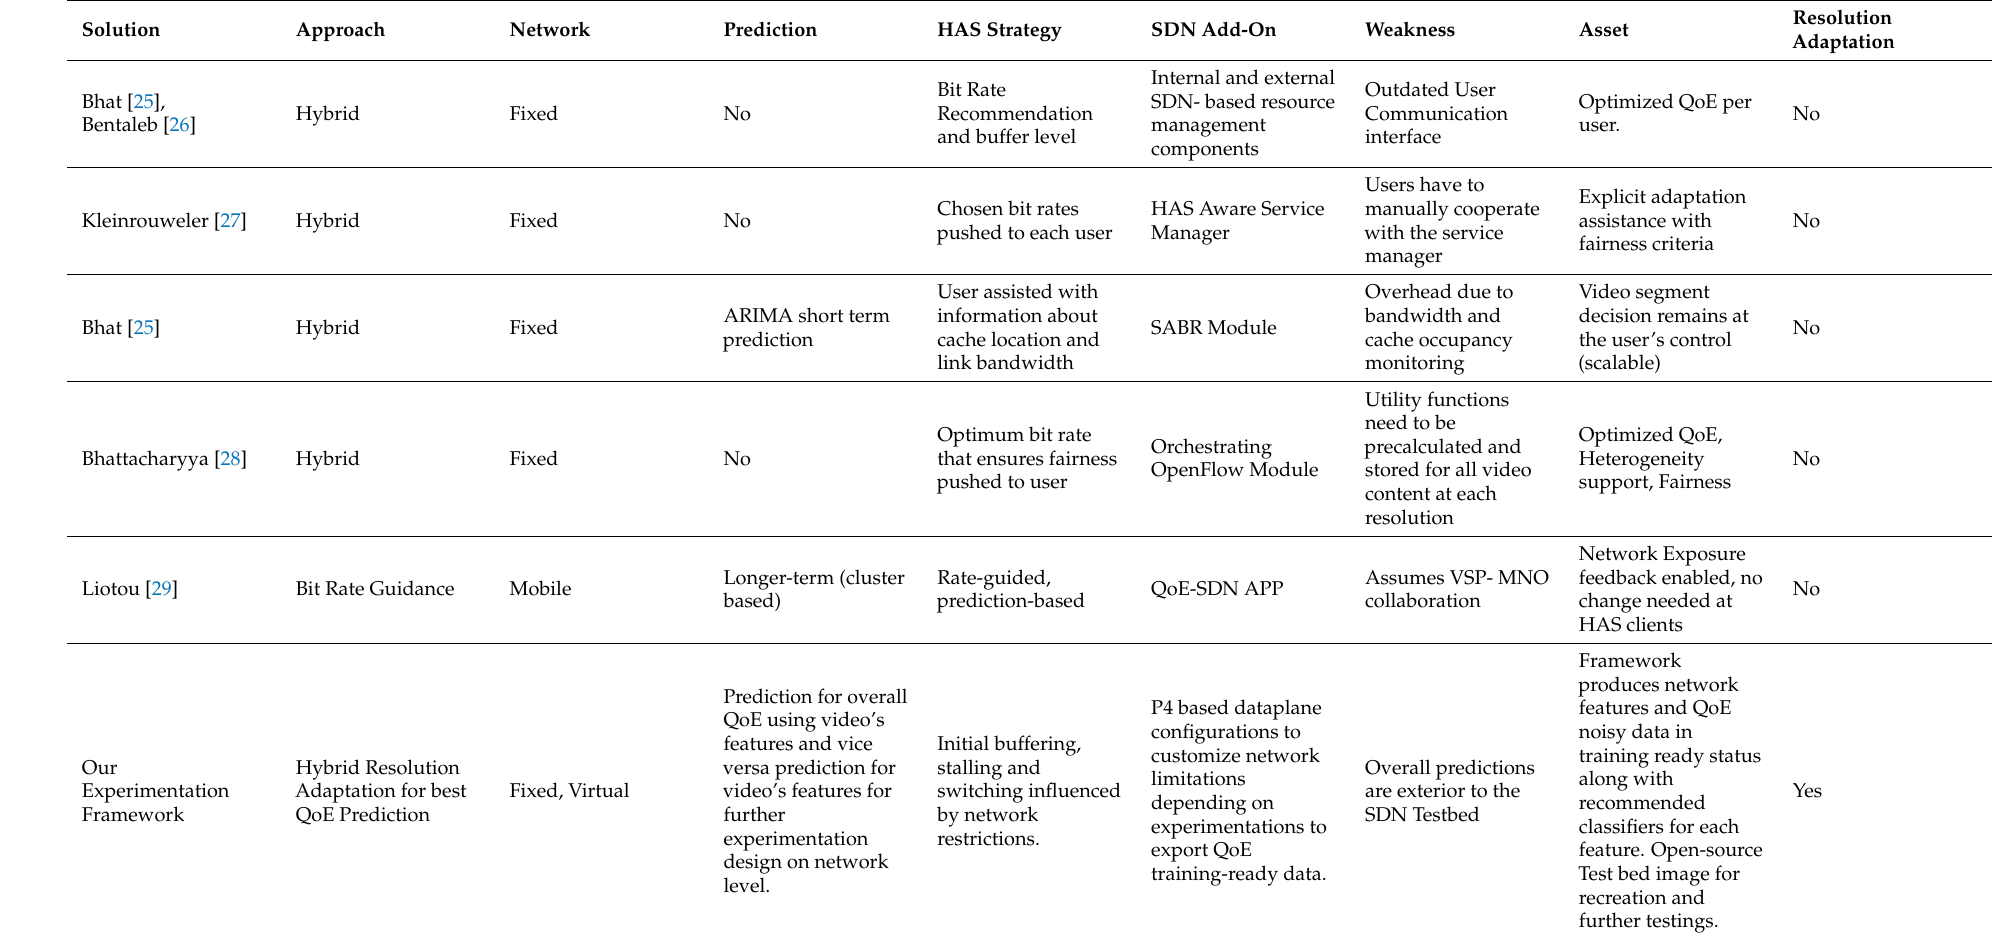
Table 10. State of Art